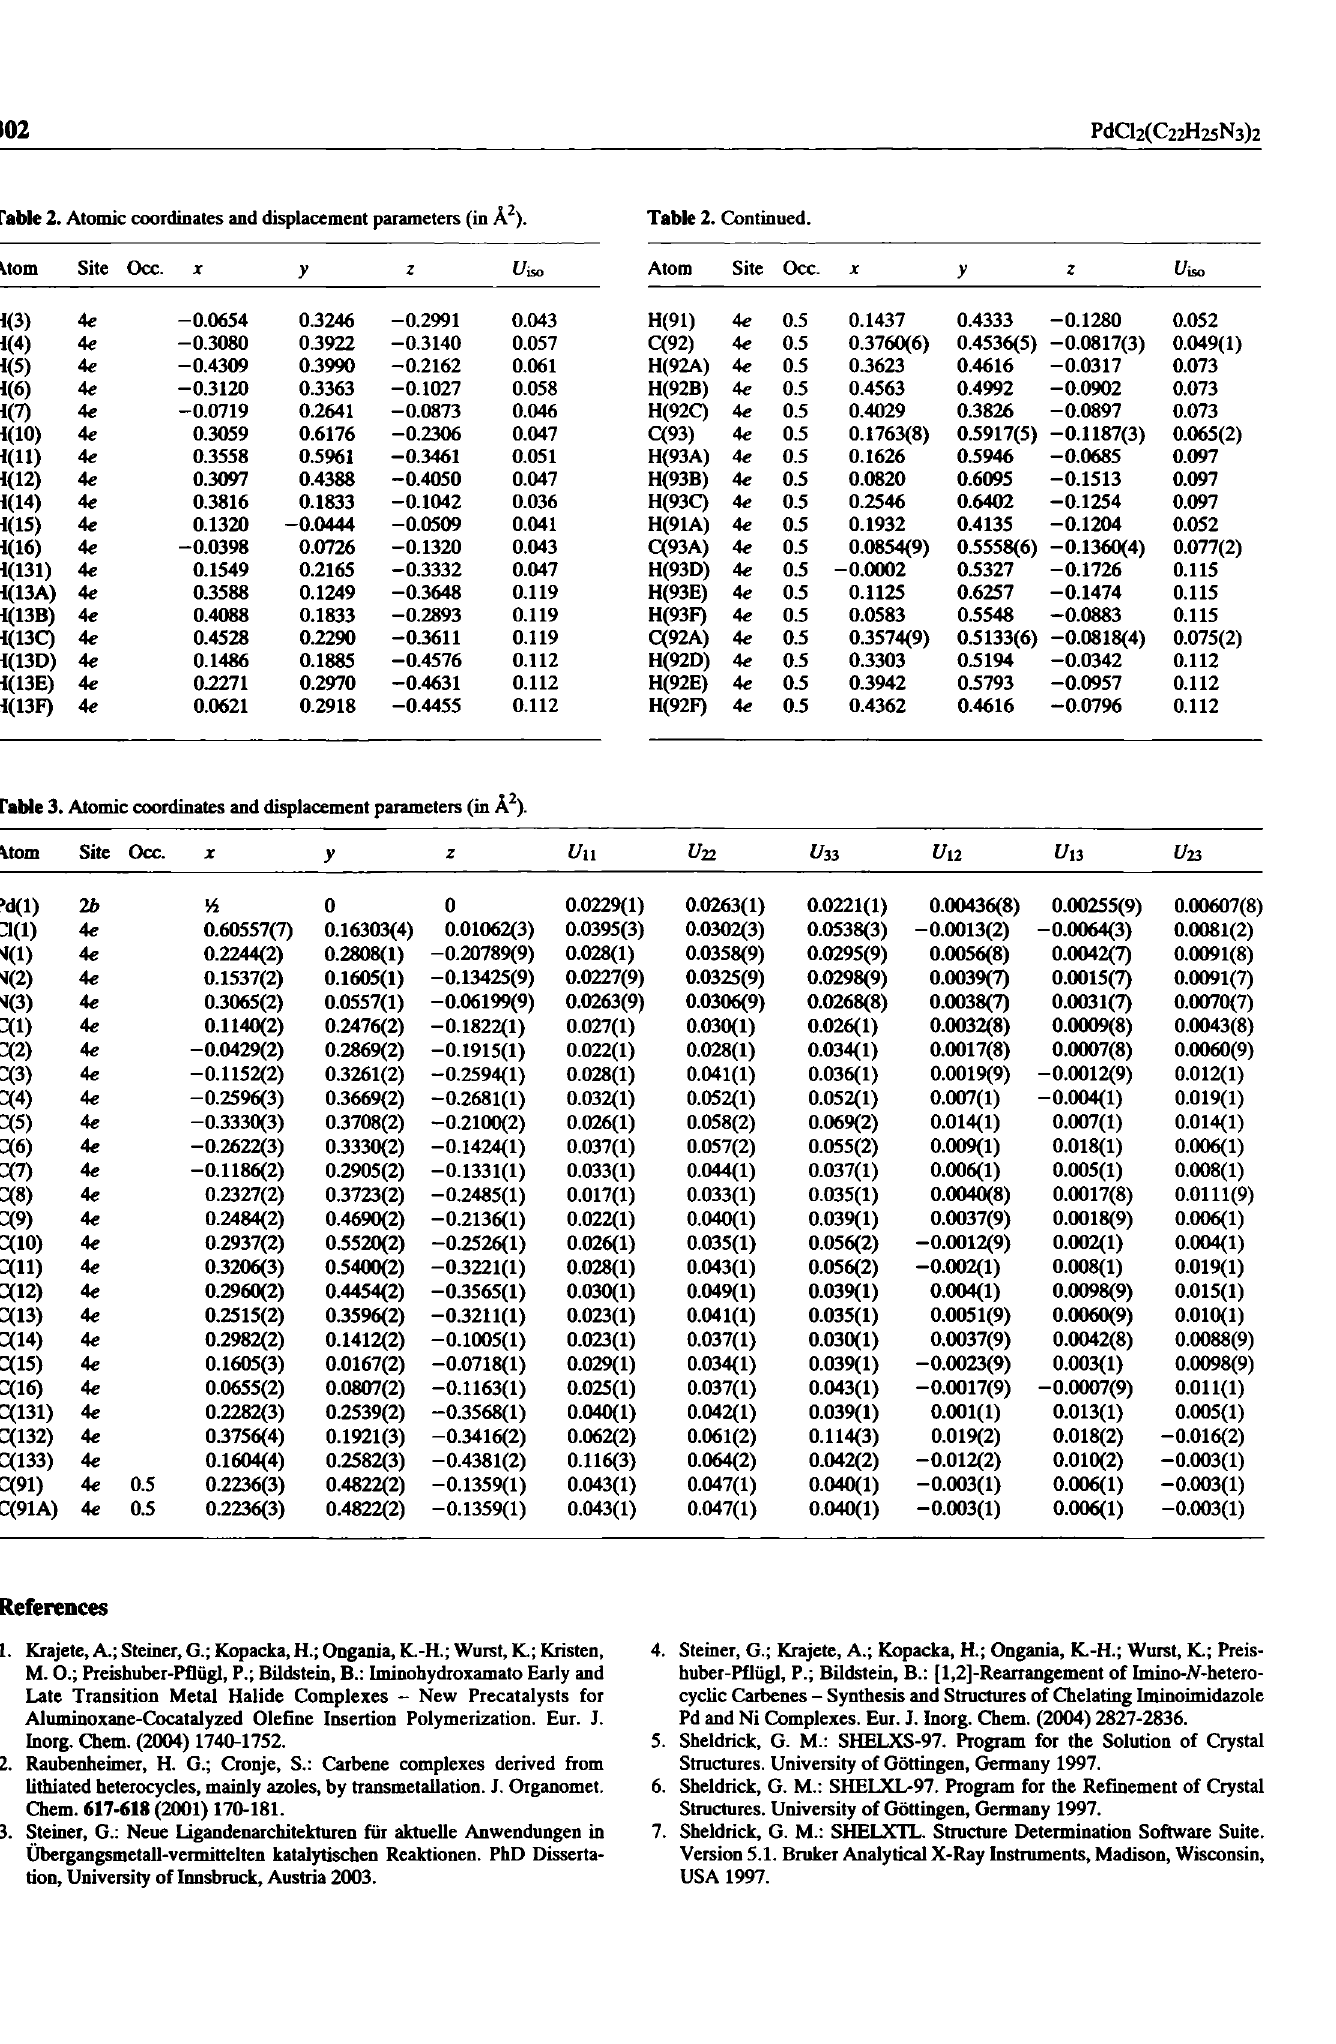
Table 3. Atomic coordinates and displacement parameters (in A 2